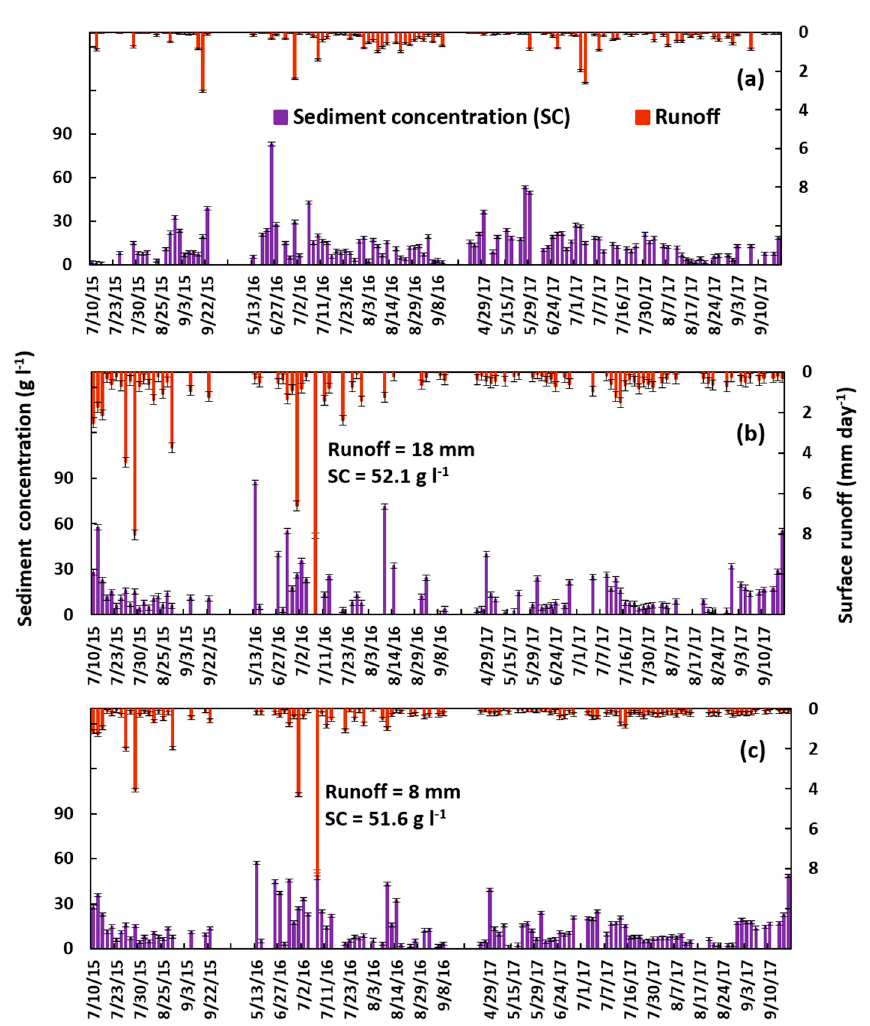
Figure 9. Surface runoff and sediment concentration for ( a ) forested watershed at weir-2, ( b ) the agricultural downstream area, and ( c ) Gomit watershed at weir-1.